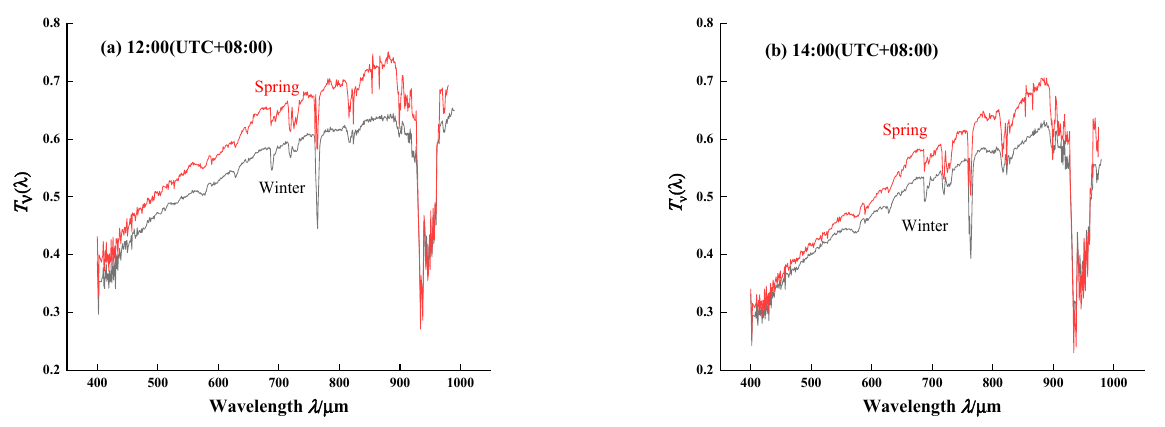
Figure 13. Comparison of continuous spectrum transmittance in winter and spring. Figure 14 illustrates the atmospheric vertical transmittance at five wavelengths of 400 nm, 500 nm, 670 nm, 780 nm, and 870 nm during the two observation days on January 29 and March 4, respectively. With increasing wavelengths, the value of the entire atmospheric transmittance of four wavelengths increases gradually. The corresponding continuous spectrum transmittance of wavelengths in Figure 12 also shows an increasing trend from visible to near-IR, which further verifies the reliability of the measured result.